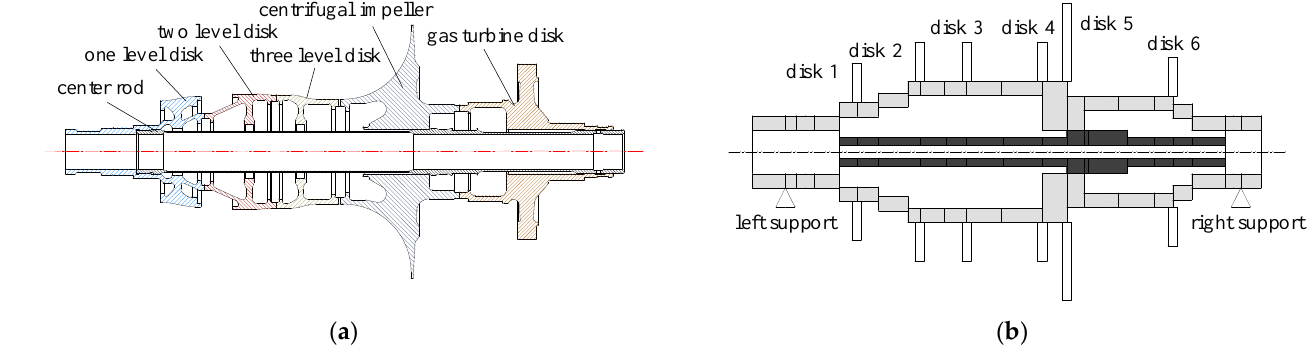
Figure 4. The simulated gas generator rotor: ( a ) structural diagram; ( b ) finite element